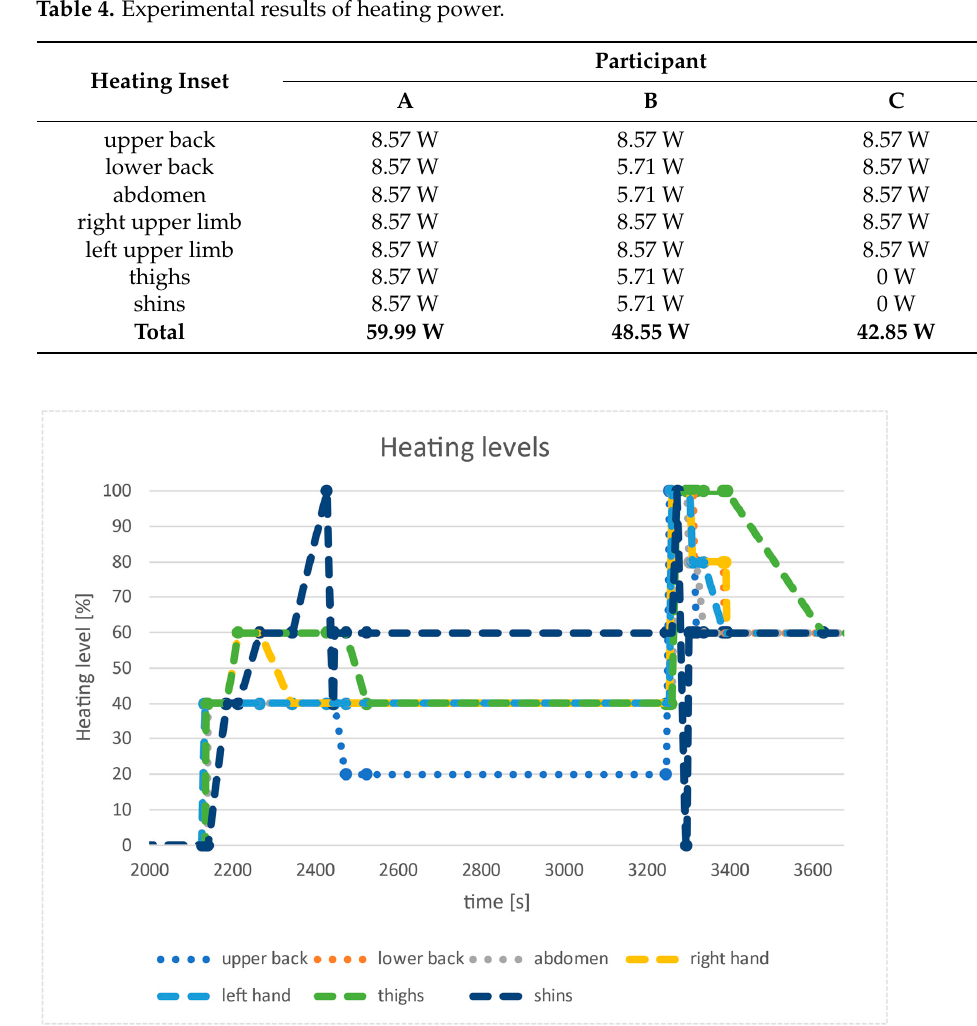
Figure 6. Heating levels for participant A when adjusting to reach subjective thermal comfort.